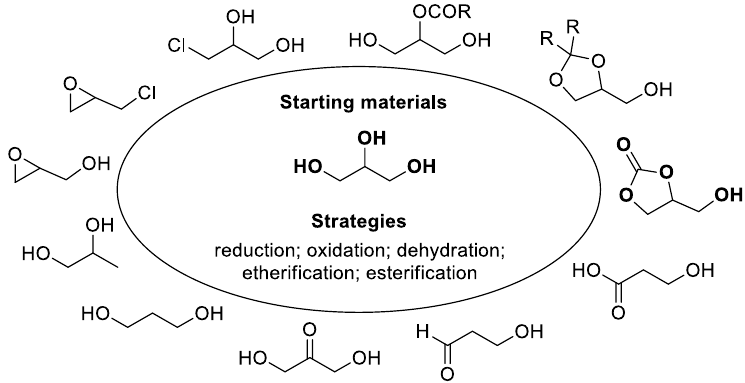
Figure 2. Diversity in glycerol transformations.